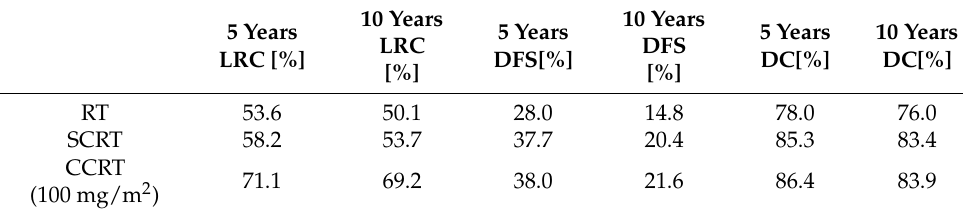
Table 3. Clinical trial 2 RT vs. SCRT vs.